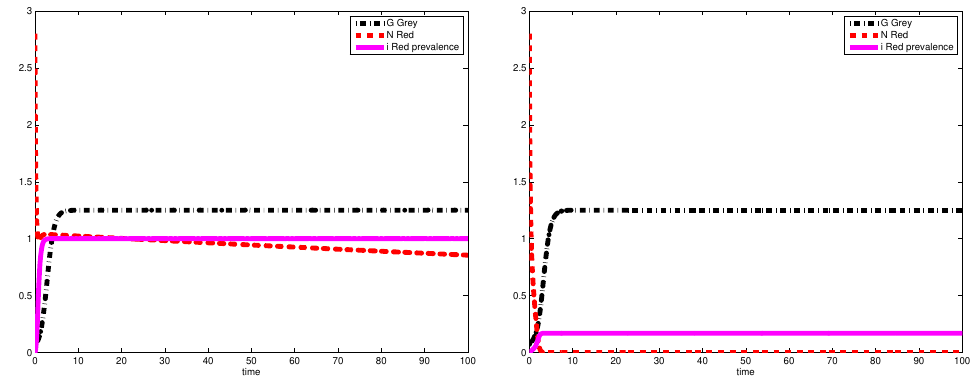
Figure 2. The three populations are plotted versus time: G grey squirrels, dash-dotted; N total red squirrels, dashed; i disease prevalence among red squirrels, continuous line. ( Left frame ) This is the current situation obtained with the basic parameter values (3), but µ = 0.002. The red squirrels would eventually disappear, but in a much longer time span. ( Right frame ) This is the situation with the basic parameter values (3), but taking a ten-times higher value of the natural plus disease-related mortality, µ = 20.0. The red squirrel population still vanishes, but now, not all its individuals will be affected by the epidemics. This of course is no help in the preservation cause of the native squirrel